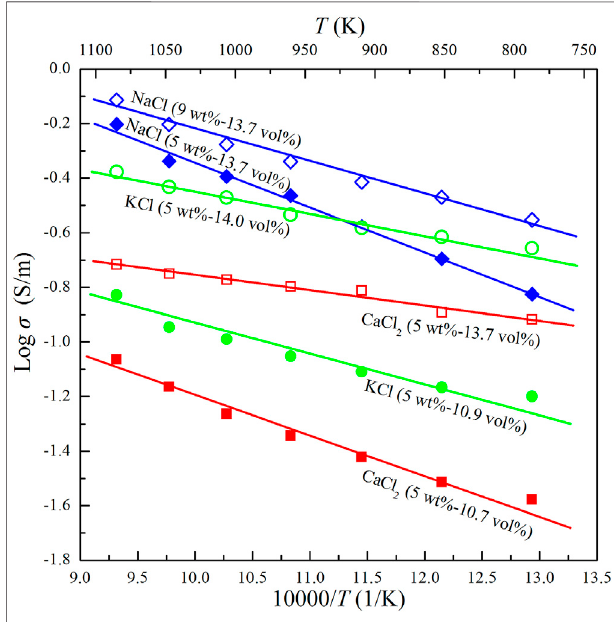
FIGURE 6 | Electrical conductivities of the Ol – NaCl – H 2 O, Ol – KCl – H 2 O and Ol – CaCl 2 – H 2 O systems with various salinity and fl uid fraction conditions at 2.0 GPa and 773 – 1073